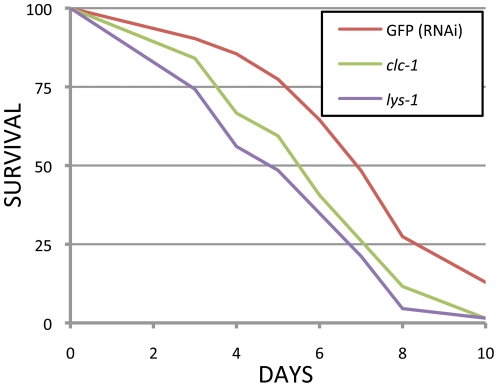
Survival of RNAi treated adults on S. aureus.
clc-1 and lys-1 RNAi treatment increased pathogen sensitivity compared to the RNAi control (GFP). One of two independent tests is shown. The TD50 (time required for 50% of the nematodes to die) for lys-1 was 4.7 days (p<0.0001) and for clc-1 was 5.4 days (p = 0.001) compared to 6.8 days for the GFP RNAi control. p-values were calculated using the log-rank test.